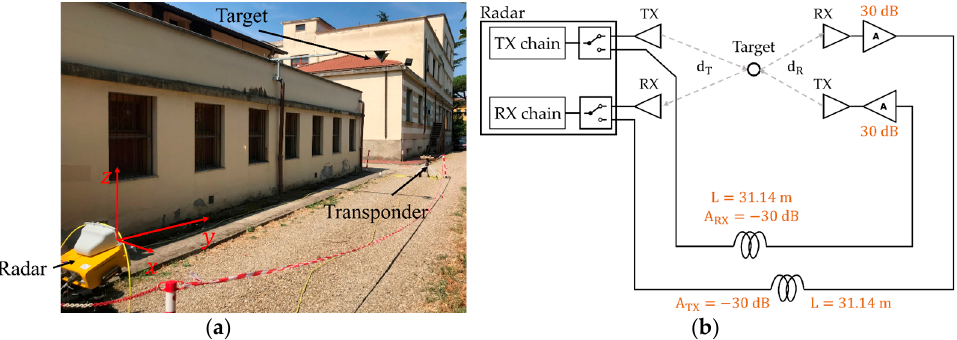
Figure 7. Experimental setup for verification of Equation (1): ( a ) picture of experimental setup, ( b ) block scheme used.